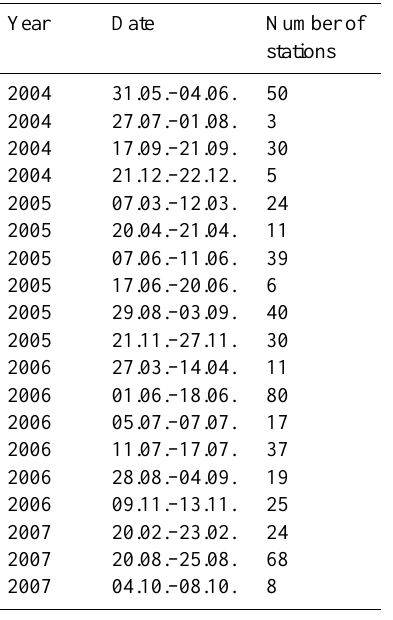
Fig. 8. Geographical coverage of sampling stations present in the 2004–2007